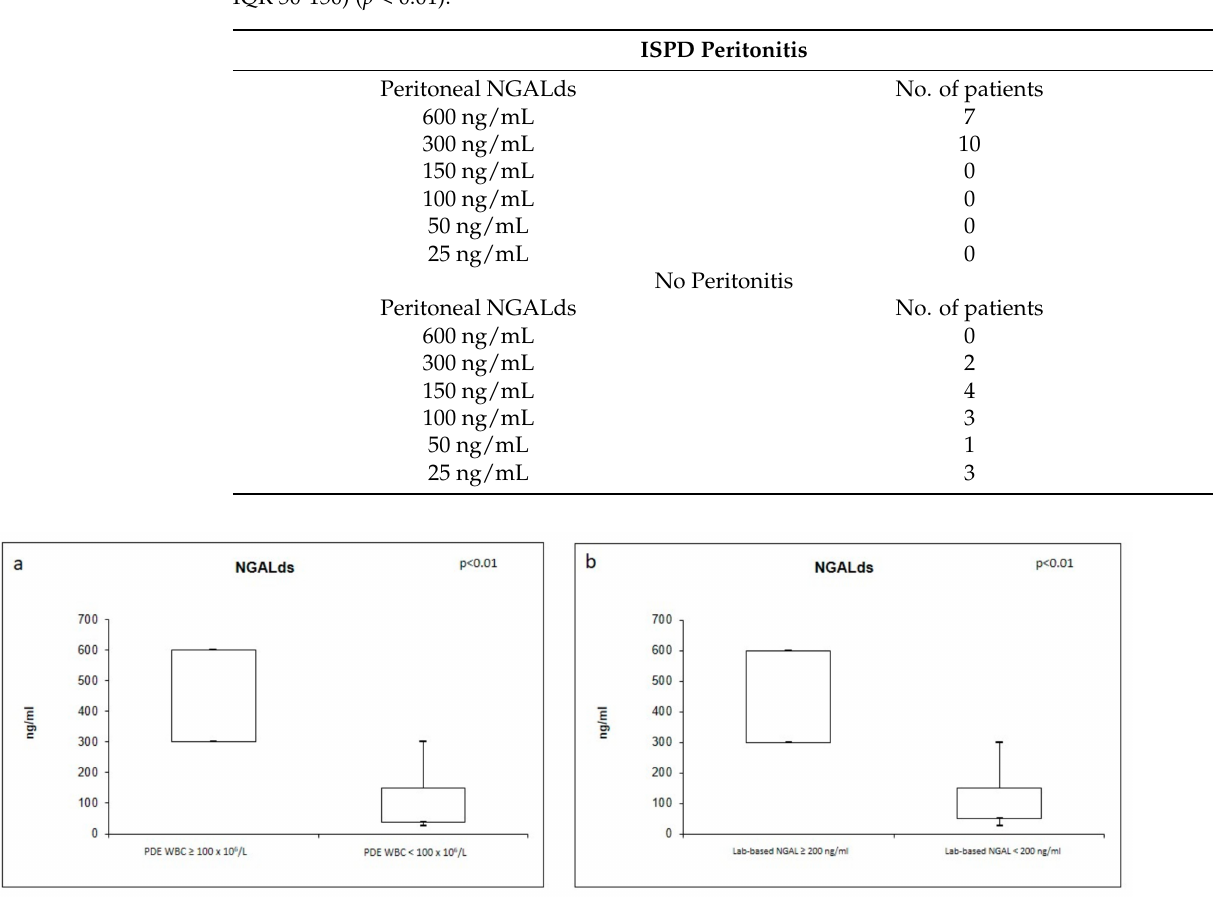
Table 4. Peritoneal NGALds in PD patients with peritonitis and without peritonitis (100 ng/mL, IQR 50-150) ( p < 0.01).